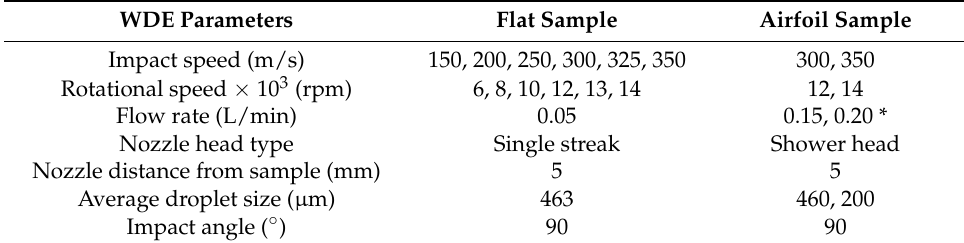
Figure 5. Schematic illustration of the WDE testing direction with respect to ( a ) T ‐ shaped flat and ( b ) airfoil treated surfaces. Table 2. WDE test parameters used in this work.